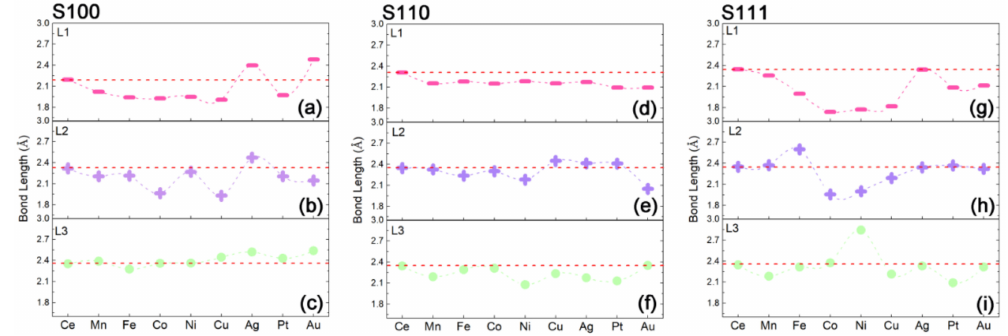
Figure 4. The evolution of M–O bond length as the function of M substitutions for each M x Ce 1 − x O 2 slab: ( a – c ) for S100 system with M in L1 ( a ), L2 ( b ) and L3 ( c ), ( d – f ) for S110 system with M in L1 ( d ), L2 ( e ) and L3 ( f ), and ( g – i ) for S111 system with M in L1 ( g ), L2 ( h ) and L3 ( i